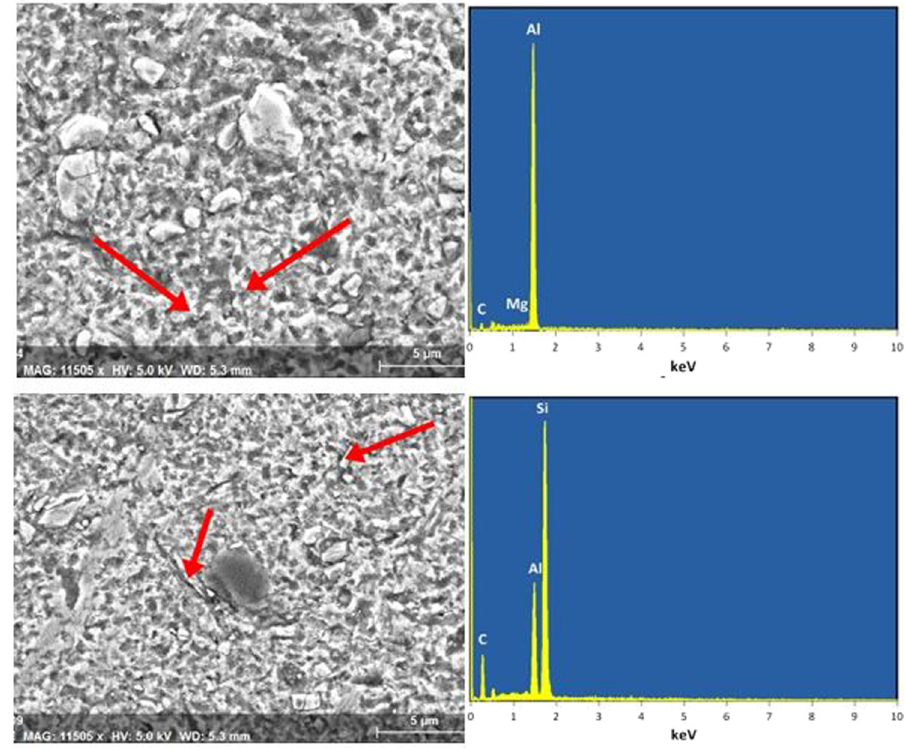
Figure 8: SEM - EDS analyses of friction stir spot welding zone: 2,000 rpm and 2 s dwell